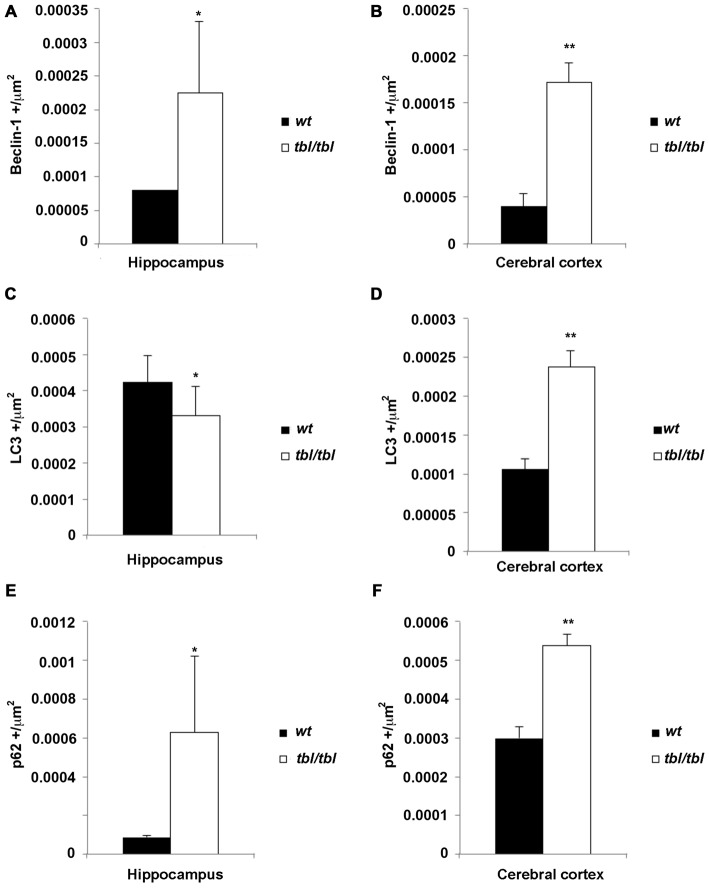
Histograms of Beclin-1 (A,B), LC3 (C,D), and p62 (E,F) immunoreactivity densities through the CA3 hippocampus and frontal neocortex of 4-month-old wt mice (black bars), and the same brain regions of 4-month-old tbl/tbl mice (white bars). In the hippocampus the differences of immunoreactivity densities are not statistically significant (asterisks), being p > 0.5 for Beclin-1, p = 0.440 for LC3, and p = 0.397 for p62. In contrast, the differences of immunorectivity densities are statistically significant for the three autophagic cycle markers in the cerebral cortex (double asterisks; p = 0.019 for Beclin-1, p = 0.019 for LC3, and p = 0.017 for p62).